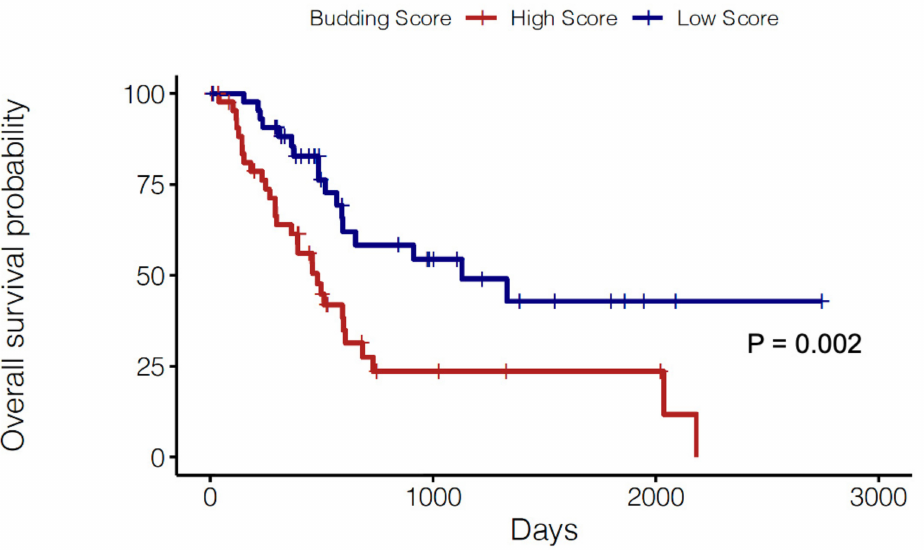
Figure 4. Prognostic role of tumor budding gene signature. Kaplan-Meier curves comparing the OS of PDAC cases from TCGA with a High (red) vs. Low (blue) Score for the molecular budding signature. Cases were dichotomized as high or low by top and bottom quartiles of expression ( n = 45 patients each). Statistical comparisons were performed using the log-rank test. The budding gene score was computed using the singscore package in Bioconductor (see